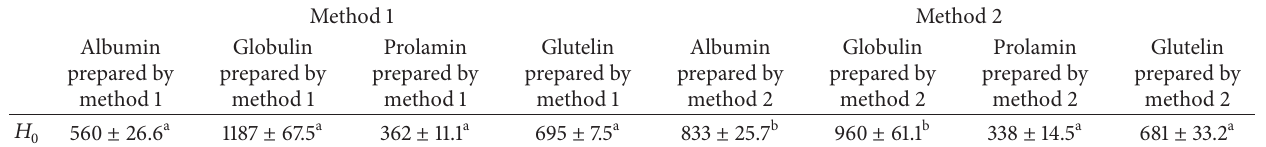
Table 2: Surface hydrophobicity ( 𝐻 0 ) of FRBPs prepared by the two extraction methods a .